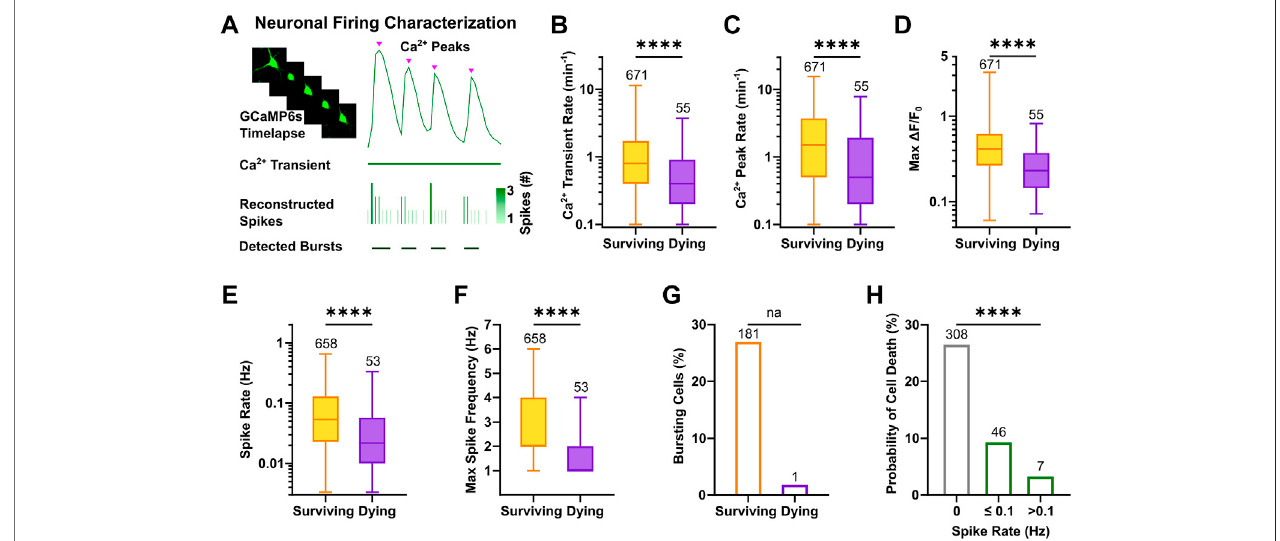
FIGURE 4 | High frequency fi ring patterns promote neuronal survival. (A) Schematic overview of single neuron fi ring properties. (B – D) Rate of calcium transients and peaks as well as the maximum Δ F/F 0 at DIV 9 were higher in neurons with a prospective survival fate (Mann-Whitney test). (E,F) Reconstructed spike rate and maximum spike frequency were higher in active neurons, which survived (Mann-Whitney test). (G) Bursts were almost exclusively detected in surviving neurons. (H) Probabilityofcelldeath wasnegatively correlatedwithspike rateofindividual neurons (Chi-square test).Boxplots withmedian and IQRand min – maxwhiskersare shown. **** p <